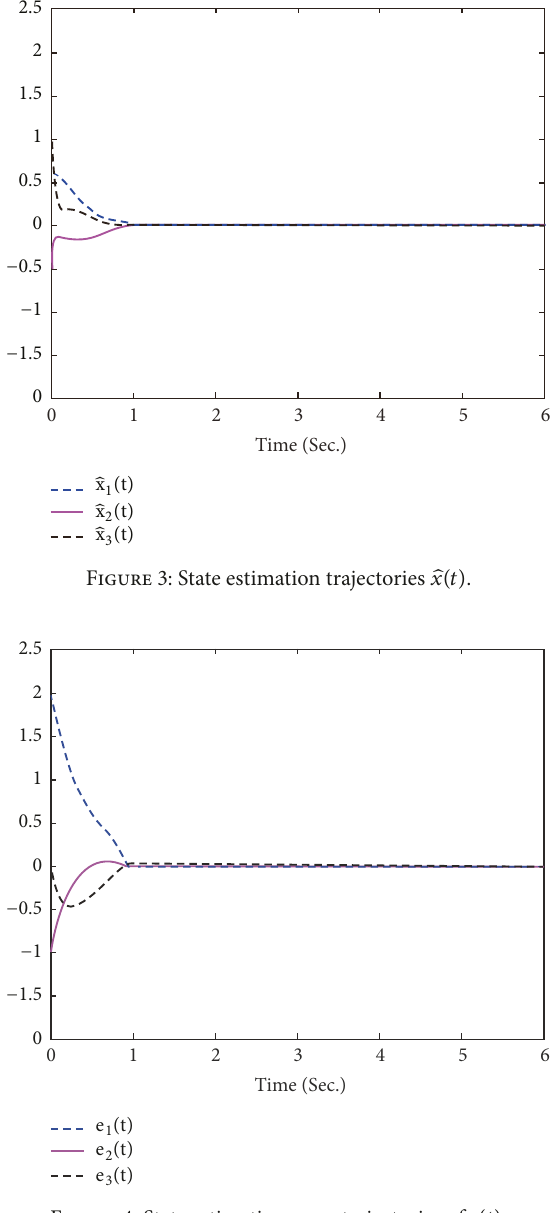
Figure 4: State estimation error trajectories of 𝑒(𝑡)